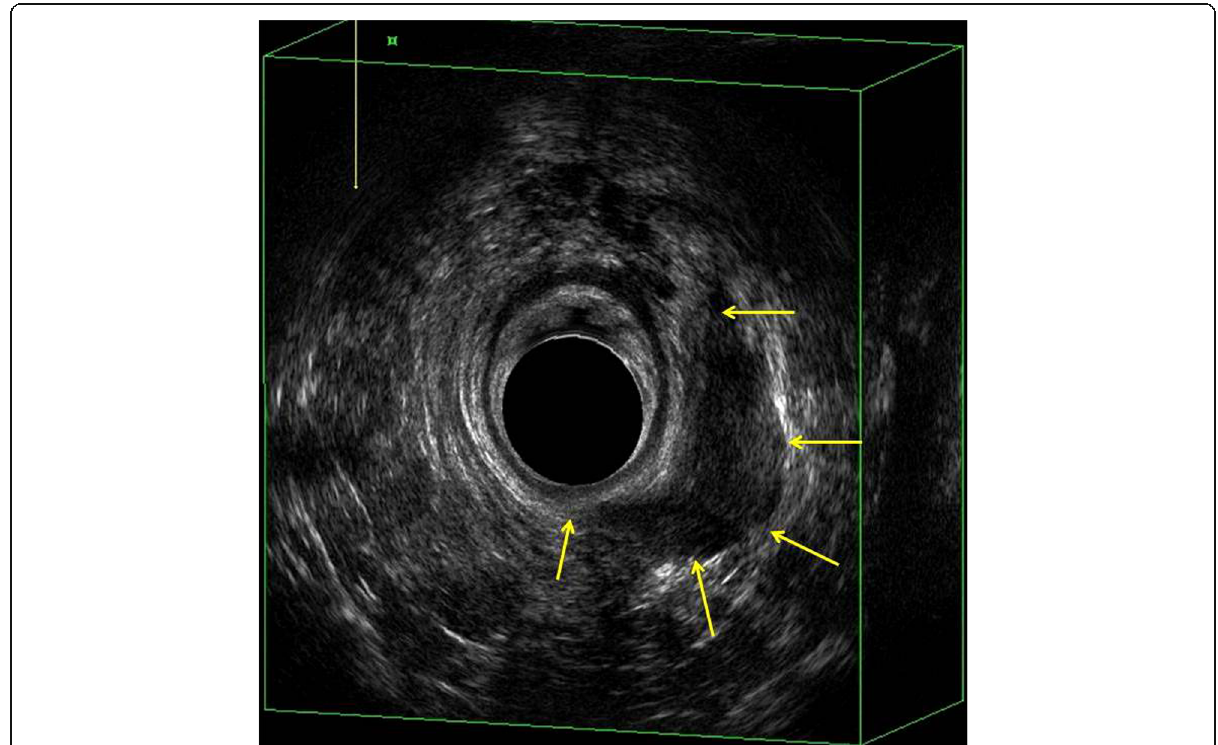
Fig. 11 3D TRUS image of transsphincteric fistula with left ischiorectal abscess (hypoechoic area marked by yellow arrows) at the level of junction of the mid- and upper anal canal